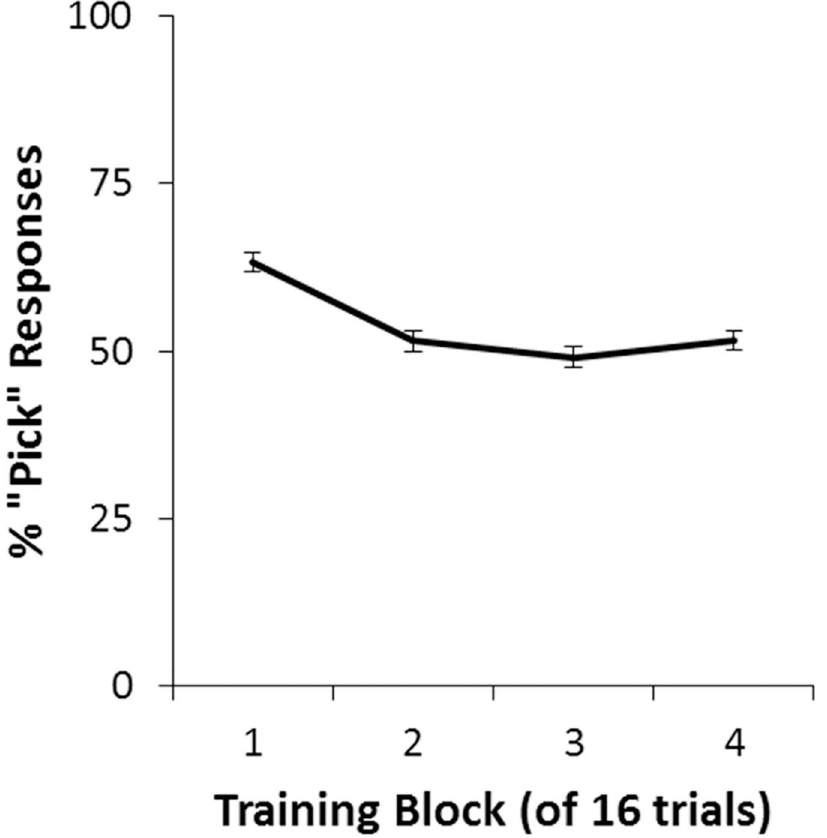
Fig 4. Percent “pick” responses per block in the training phase. Although participantstendedto make “pick” responseson about two-thirds of trials in the first block of training, the responserate approached50% in later blocks (dashedline), indicatinga balancebetween “pick” and “skip”